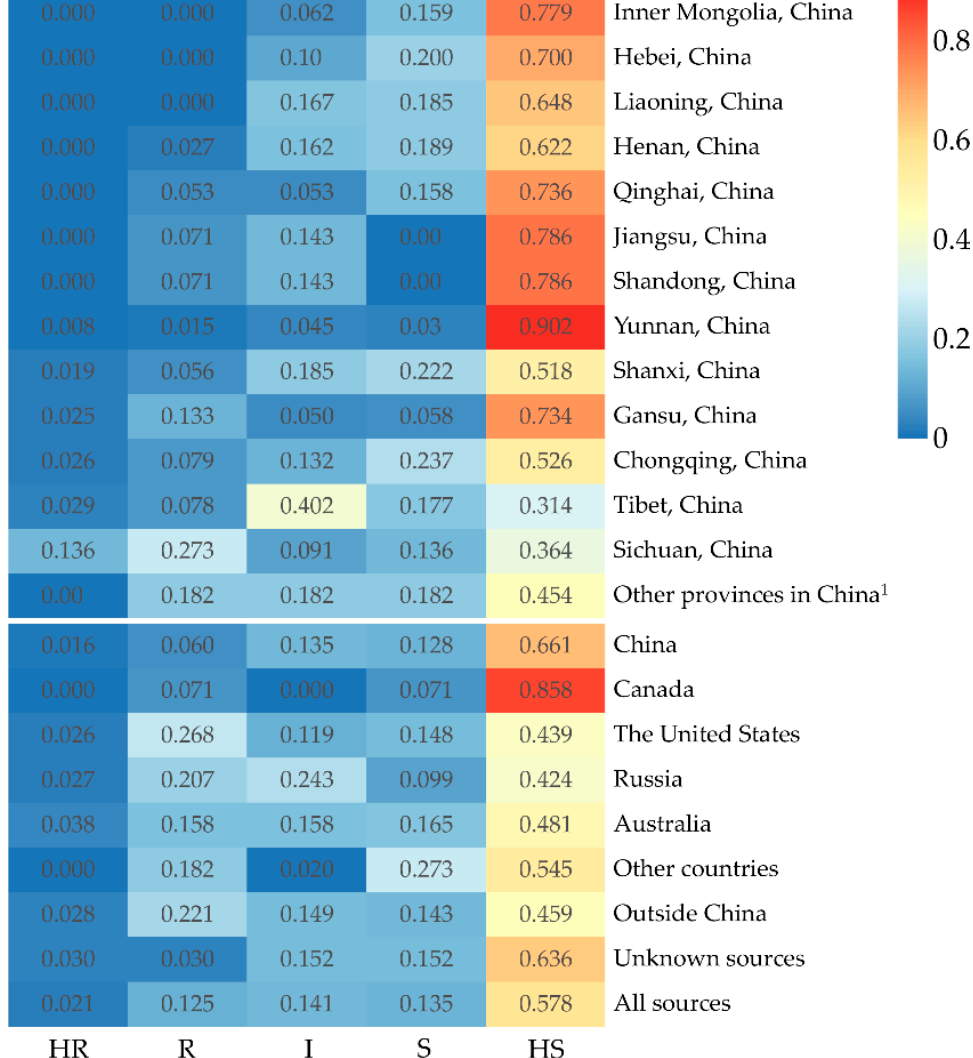
Figure 4. The percentage of accessions with five different resistance levels in peas from different sources. 1 If the number of accessions from a province in China or a country was less than 10, they would be combined into other provinces in China and other countries for the accuracy of statistical analysis, respectively.